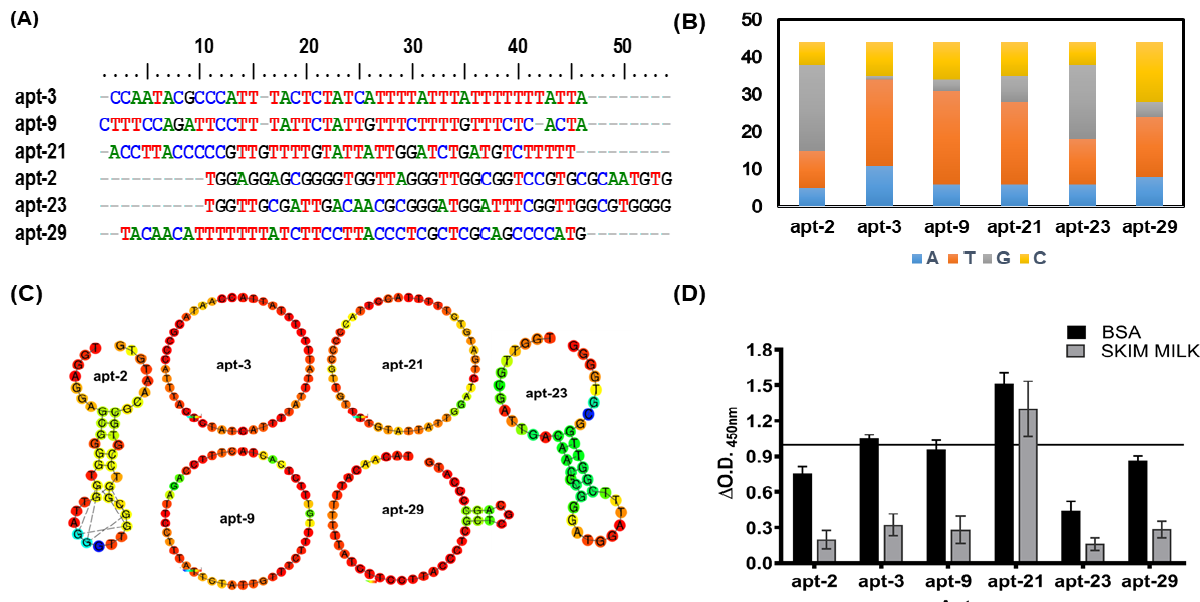
Figure 2. Evaluation of shortlisted mEVs-specific high-affinity binders: ( A ) CLUSTAL W generated primary sequence alignment of high-affinity binders as listed to the left (black); ( B ) differential dis- tribution of nucleotides (numbers, Y -axis) across each of the shortlisted high-affinity binders (X-asis); ( C ) secondary structure (RNA fold using DNA parameters, generated using a web-based tool [39]) of SELEX derived high-affinity binders; ( D ) equal numbers of Msm-specific EVs were used to determine the binding affinity (A 450nm , Y -axis) to different aptamers ( X -axis) under two blocking conditions viz. 5% BSA (black bars) and 5% skim milk (grey bars). Variance is represented as mean ± SD.